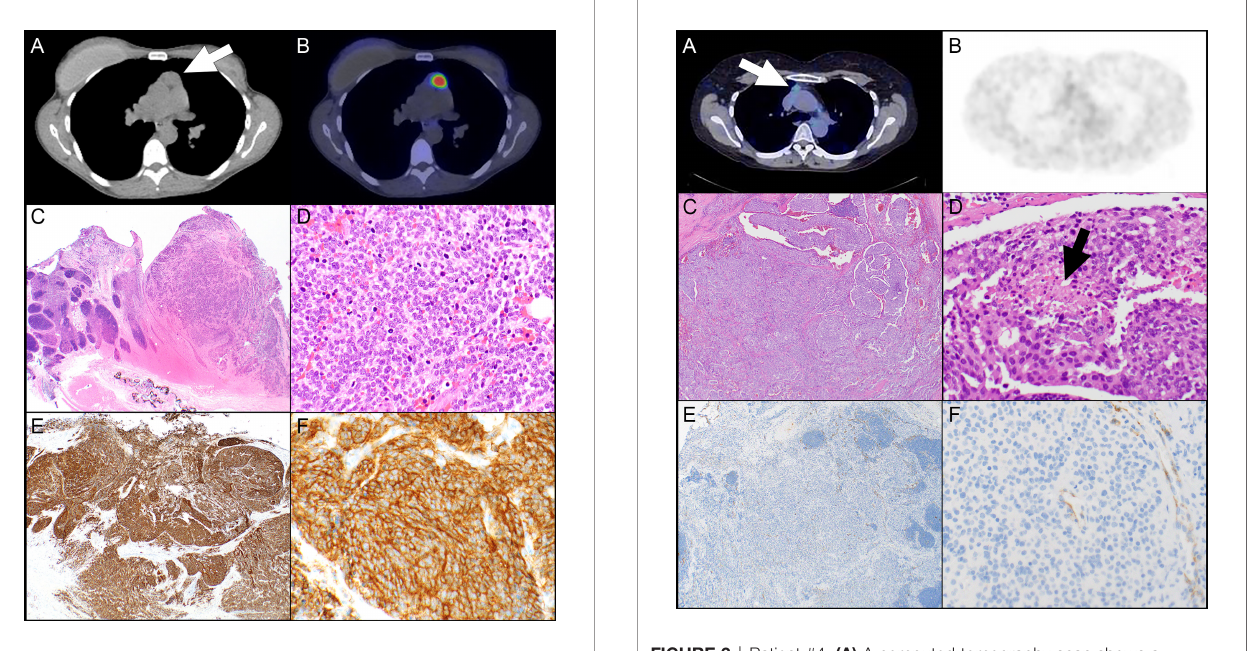
FIGURE 2 | Patient #4. (A) A computed tomography scan shows a prevascular mediastinal lesion (arrow) that shows 68Ga take up on a DOTATATE PET scan that is much lower than liver (interpreted as Krenning score 1) (B) . (C) A nested neoplasm is comprised of round to oval cells with a small amount of cytoplasm and associated with focal necrosis ( D , arrow). (E) There is no expression of SSTR2 in tumor cells. (F) Note SSTR2 expression in endothelial cells serving as internal control. Magni fi cation, H&E x 40 (C) , x 400 (D) , SSTR2 x 40 (E) , x 400 (F)